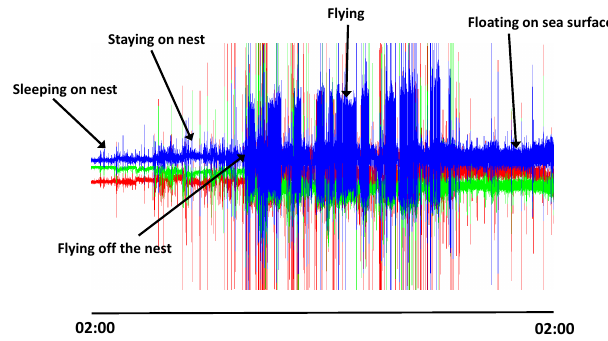
Figure 8. Accelerometer measurements for a northern gannet breeding on Heligoland. This example shows the values for the three different axes (red indicates x , green indicates y , blue indicates z ) over 24h, from 02:00 to 02:00CEST on the next day. Different ac- tivities are indicated by arrows; higher peaks indicate greater move- ment.